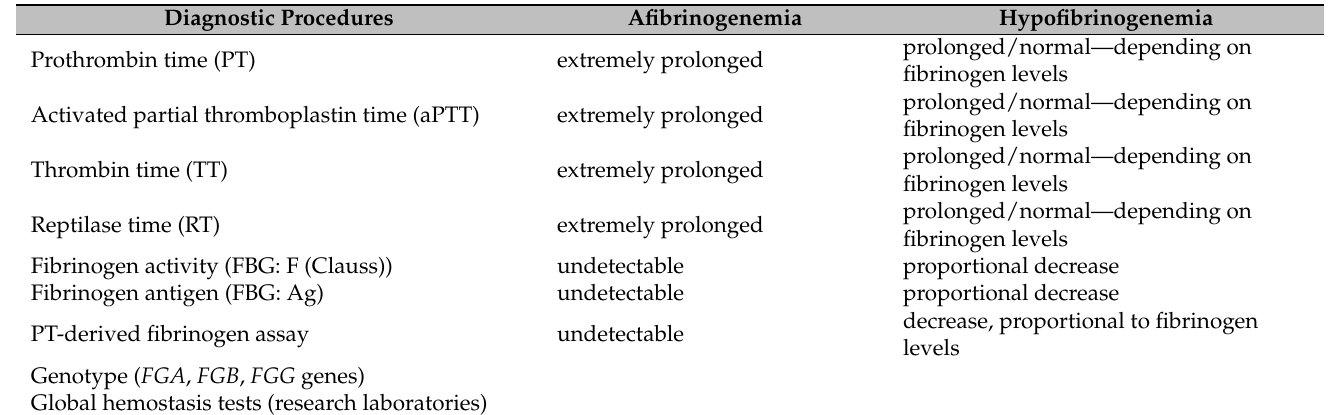
Table 2. Diagnostic procedures of quantitative fibrinogen